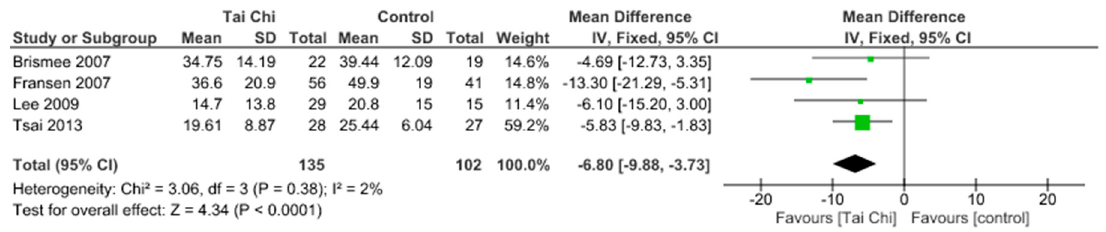
Figure 9. Function: Land-based exercise versus Control.